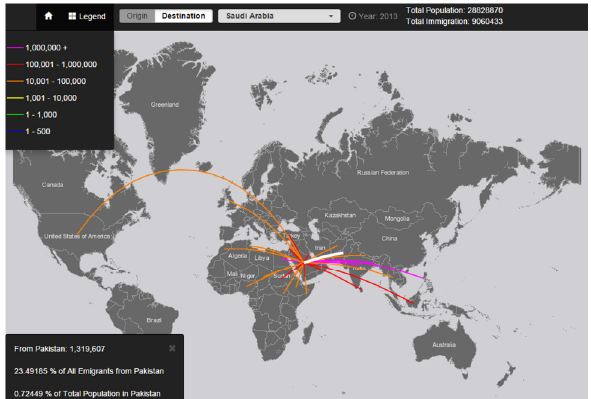
Figure 4a Immigrants to Saudi Arabia in 2013